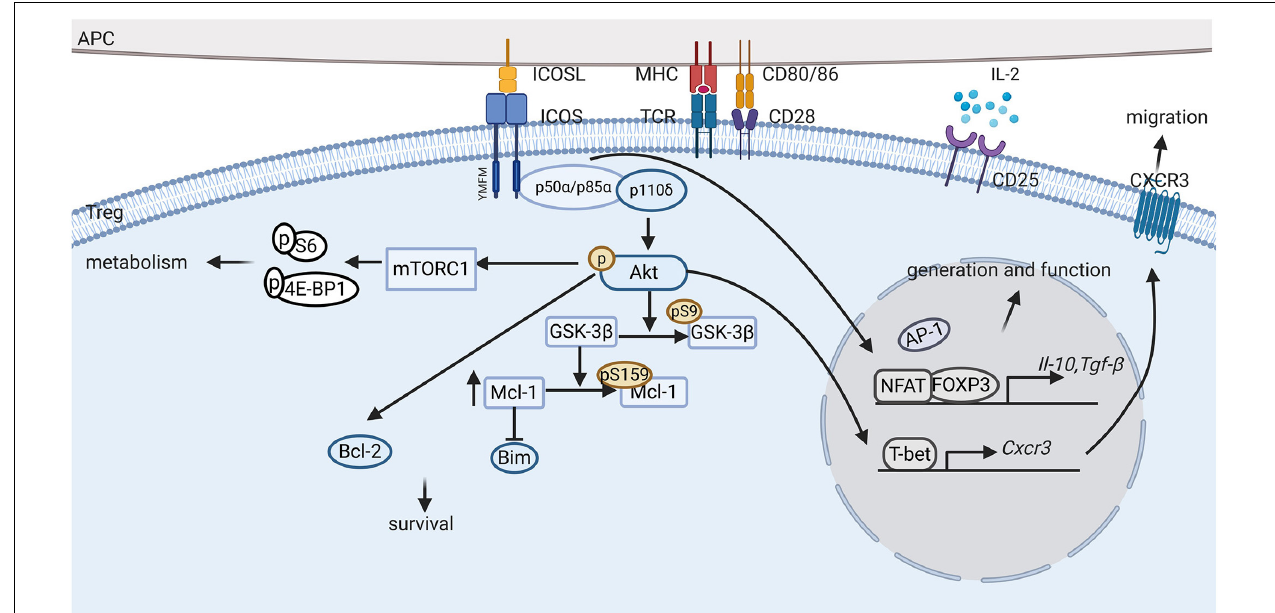
FIGURE 2 | ICOS signaling pathway in Tregs. ICOS-ICOSL interaction promotes the generation, proliferation, survival and suppressive ability of regulatory T cells (Tregs) through complex signaling pathways. First, activation of ICOS promotes Foxp3 transcription, favoring NFAT binding to FOXP3 over AP-1 and upregulating FOXP3 downstream regulatory genes, such as Il-10 and Tgf- β . Second, ICOS engagement induces PI3K recruitment to the YMFM motif at the cytoplasmic tail and the phosphorylation of Akt. Activation of Akt can induce Bcl-2 expression and inhibit pro-apoptotic Bcl-2 family protein production, thereby promoting ICOS + Treg survival. Furthermore, ICOS also activates the mTORC1 signals, which is suggested to mediate protein synthesis and metabolism in Tregs. In addition, ICOS expression elevates CXCR3 expression, which promotes the migration of Tregs to inflammatory tissues.